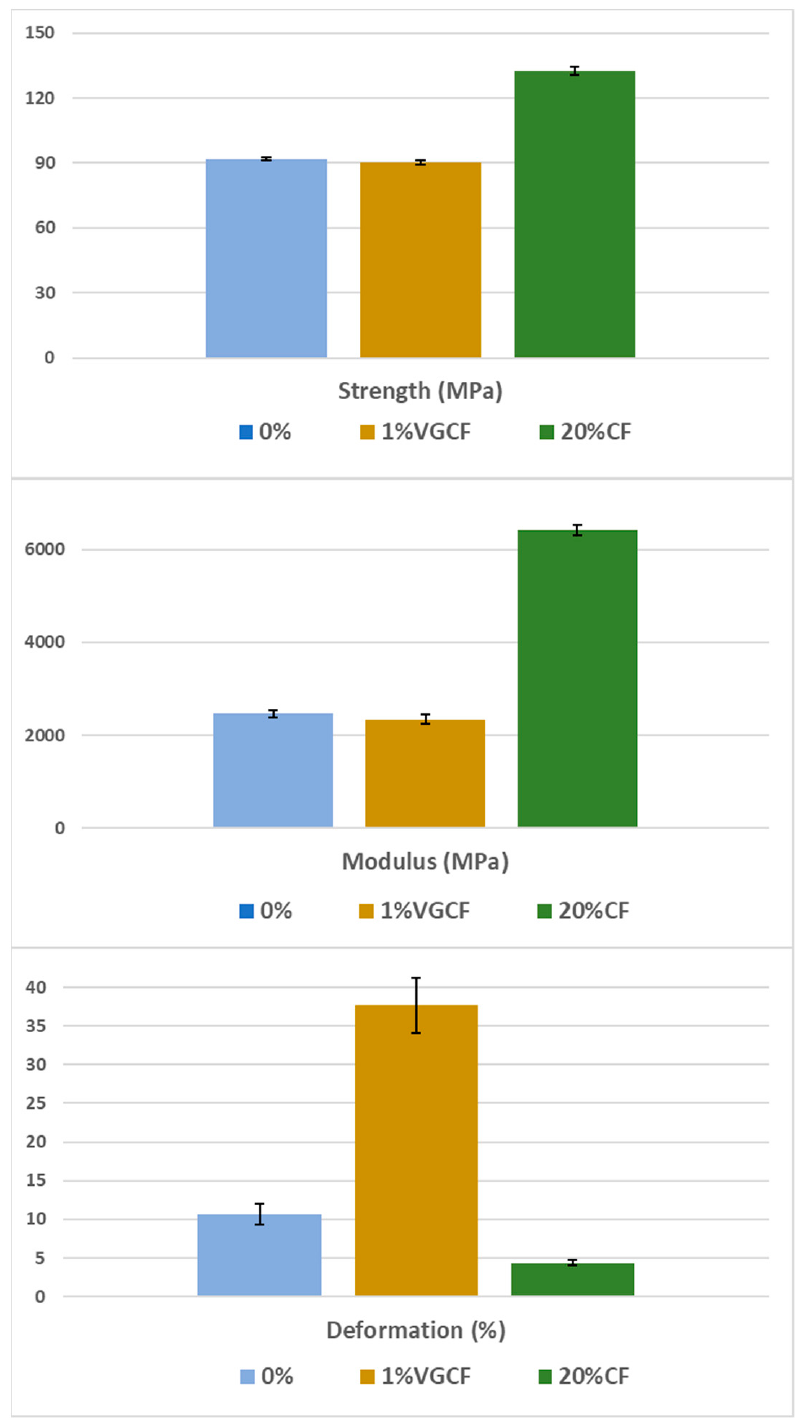
Figure 7. Mechanical characteristics of the FFF samples from R-BAPB and its composites.